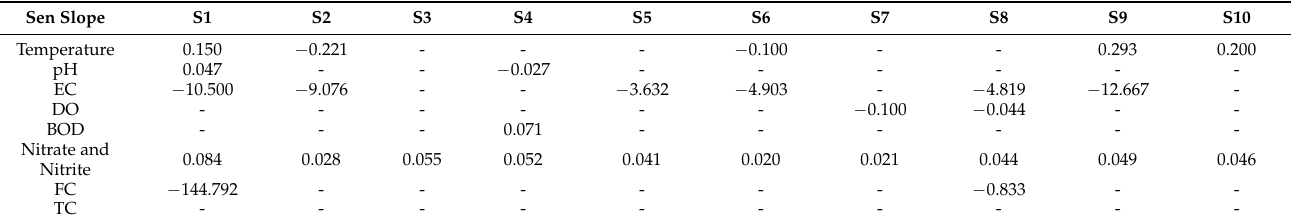
Table 1. Sen’s slope evaluation for the series of water parameters registered at the hydrological series. Sen Slope